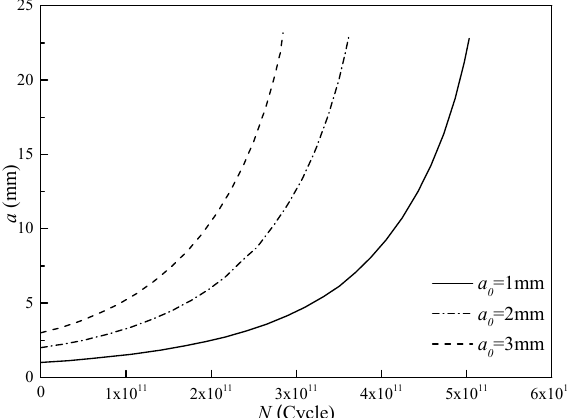
Figure 11. Relationship between crack length a and fatigue life N.